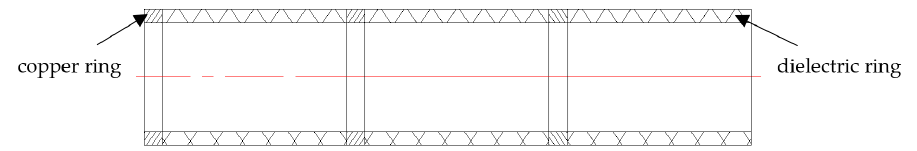
Figure 2. The schematic of the periodic dielectric loaded circuit.